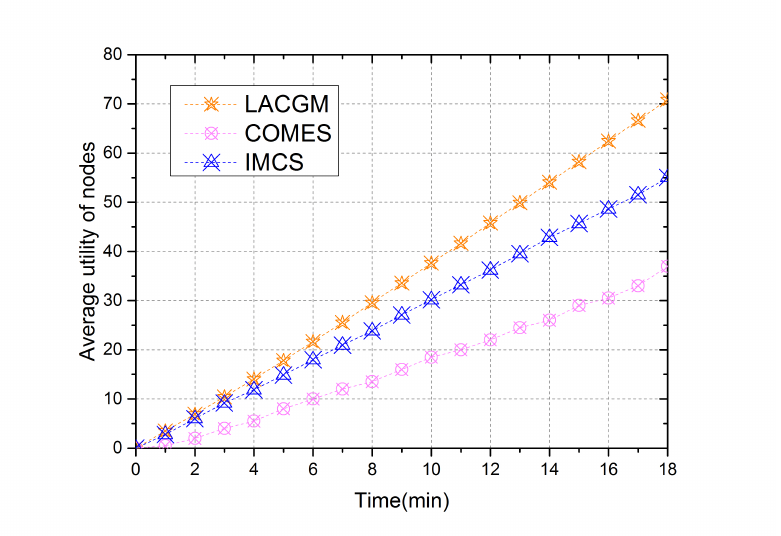
Figure 6. Average node utility changing with time ( Υ = 400, N =